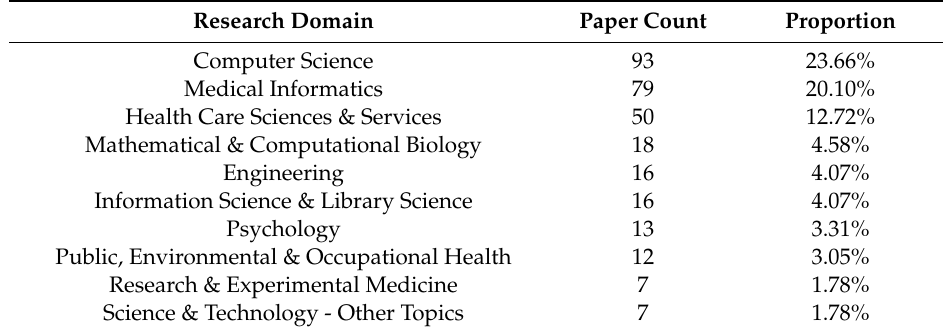
Table 3. Top research domains for the 194 papers from the Web of Science